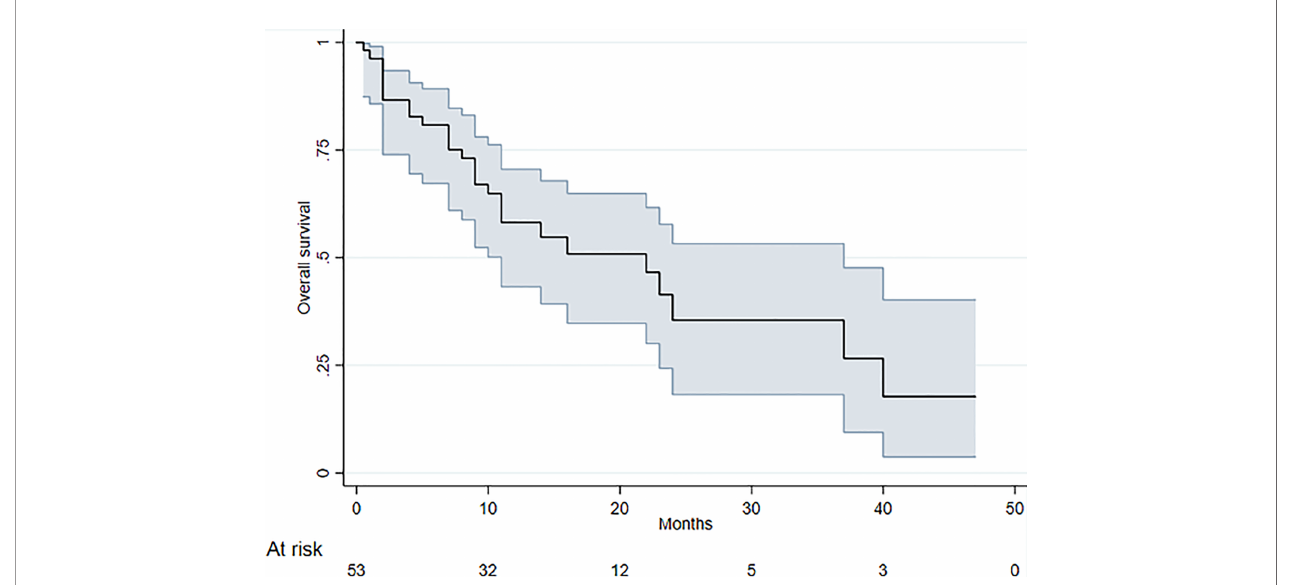
FIGURE 4 | Kaplan-Meier curves for OS (shaded region corresponds to 95% con fi dence intervals).